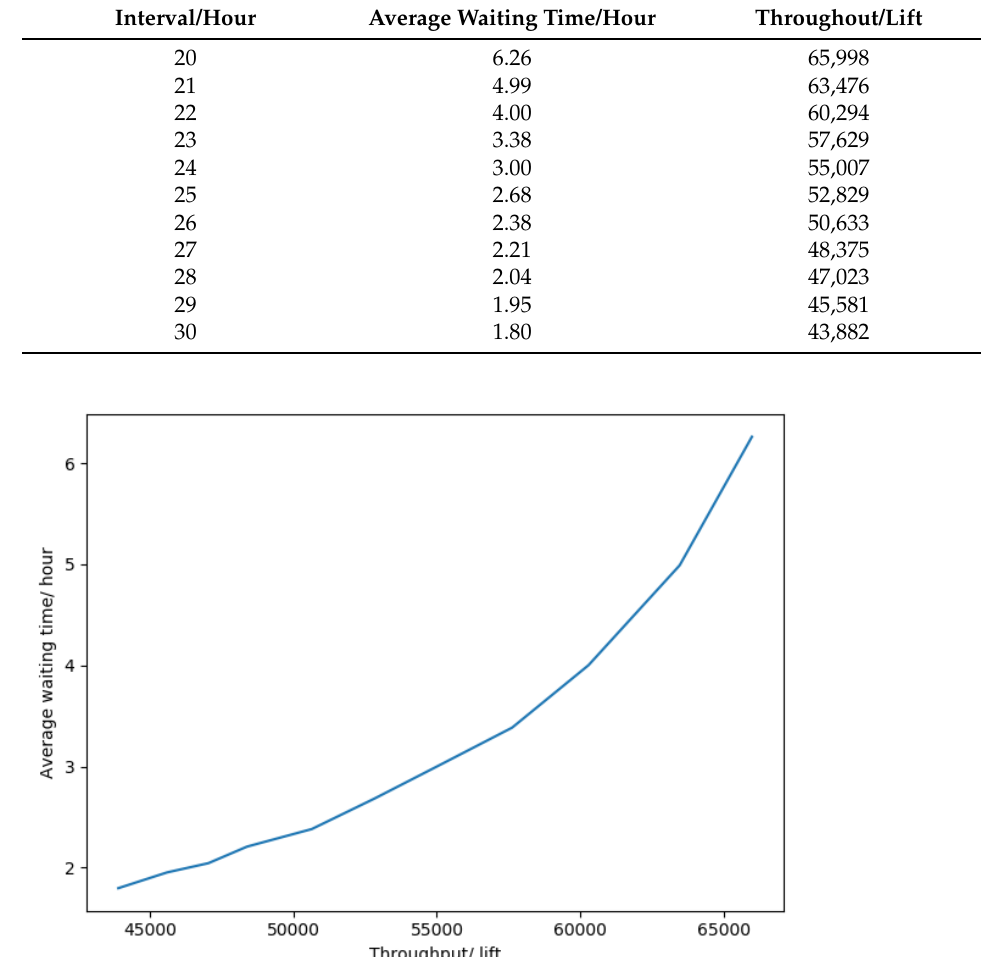
Figure 10. Throughput vs. average waiting